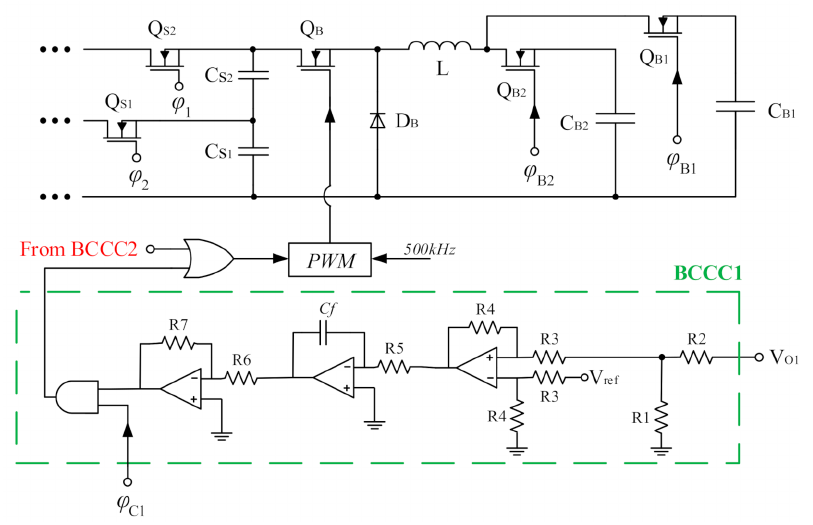
Figure 6. Closed loop model of the buck